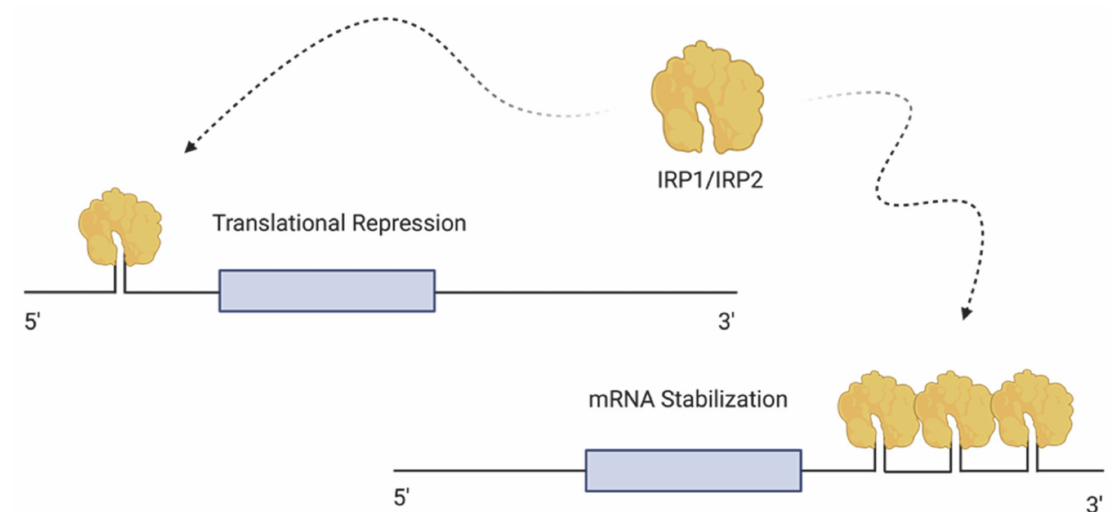
Figure 2. Cellular iron regulation. The intracellular iron pool is regulated by the binding of IRP1 and IRP2 to IRE. IRP1 and IRP2 are RNA binding proteins that interact with IRE to control the translation of proteins involved in iron metabolism. IRPs are either present at the 3 (cid:48) UTR or the 5 (cid:48) UTR of the target mRNA. When an IRP binds to a single IRE at the 5 (cid:48) UTR, mRNA translation is repressed. On the other hand, the binding of IRP to IRE at the 3 (cid:48) UTR stabilizes the transcript and leads to increased mRNA translation. The illustration was created using BioRender.com, (accessed on 3 April